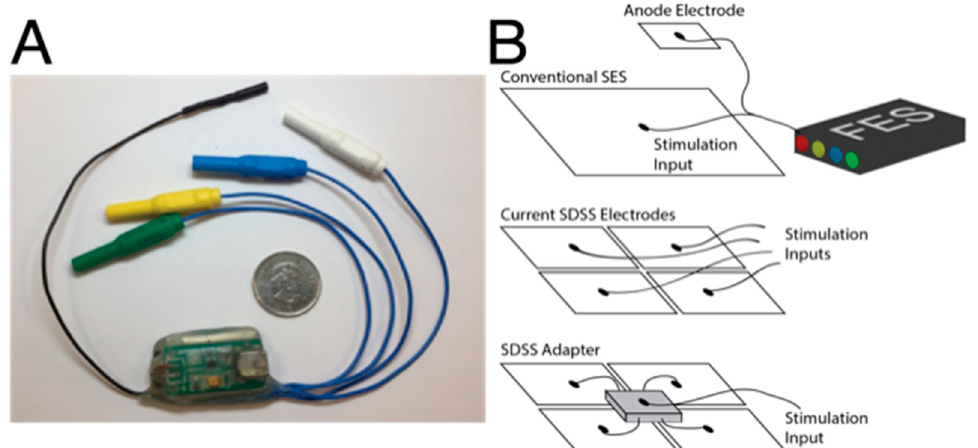
Figure 1. Sequential stimulation adapter prototype ( A ). SDSS setups without an adapter requires four input channels from the stimulator whereas a SDSS adapter requires only one input channel ( B ).